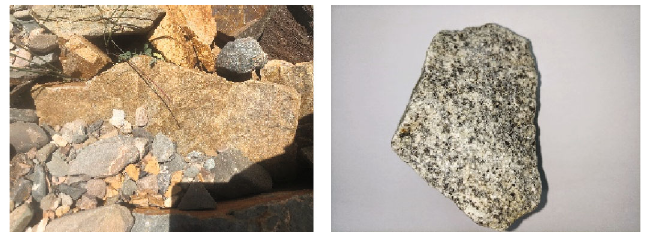
Figure 3: On-site sandstone and